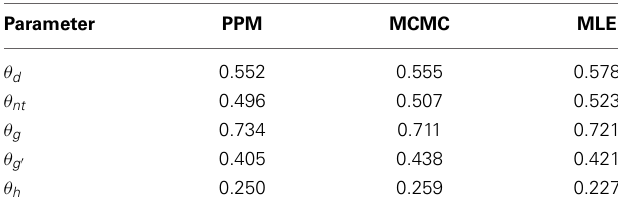
Table 1 | PPM, MCMC, and MLE values for the PD model parameters from 109 CT scans by one radiologist reported in the Hanley and McNeil (1982)